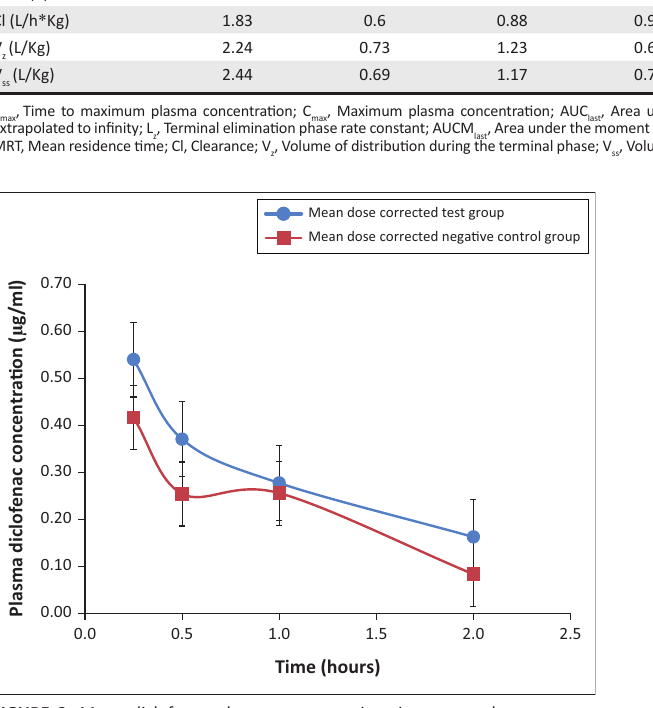
FIGURE 2: Mean diclofenac plasma concentration time curves by treatment group, dose corrected to 1